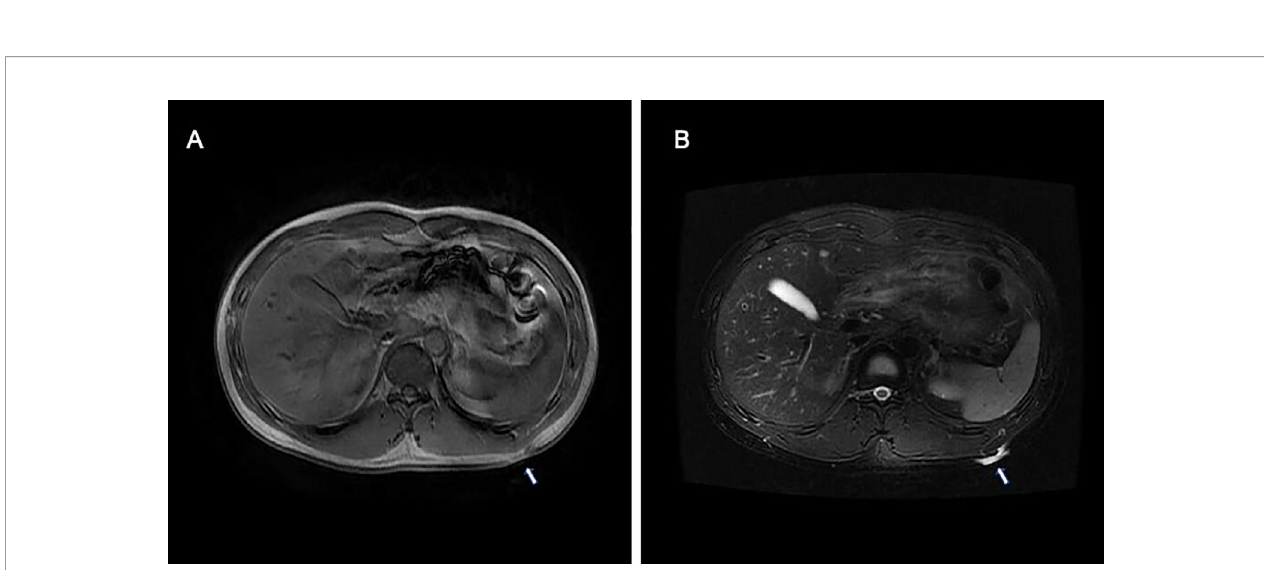
FIGURE 3 | Magnetic resonance imaging of atrophic pigmented DFSP showed a well-circumscribed plaque with adjacent tissue thinning in the left region of the trunk. (A) T1-weighted images revealed a slightly higher non-uniform signal, (B) while T2-weighted images showed a high signal.